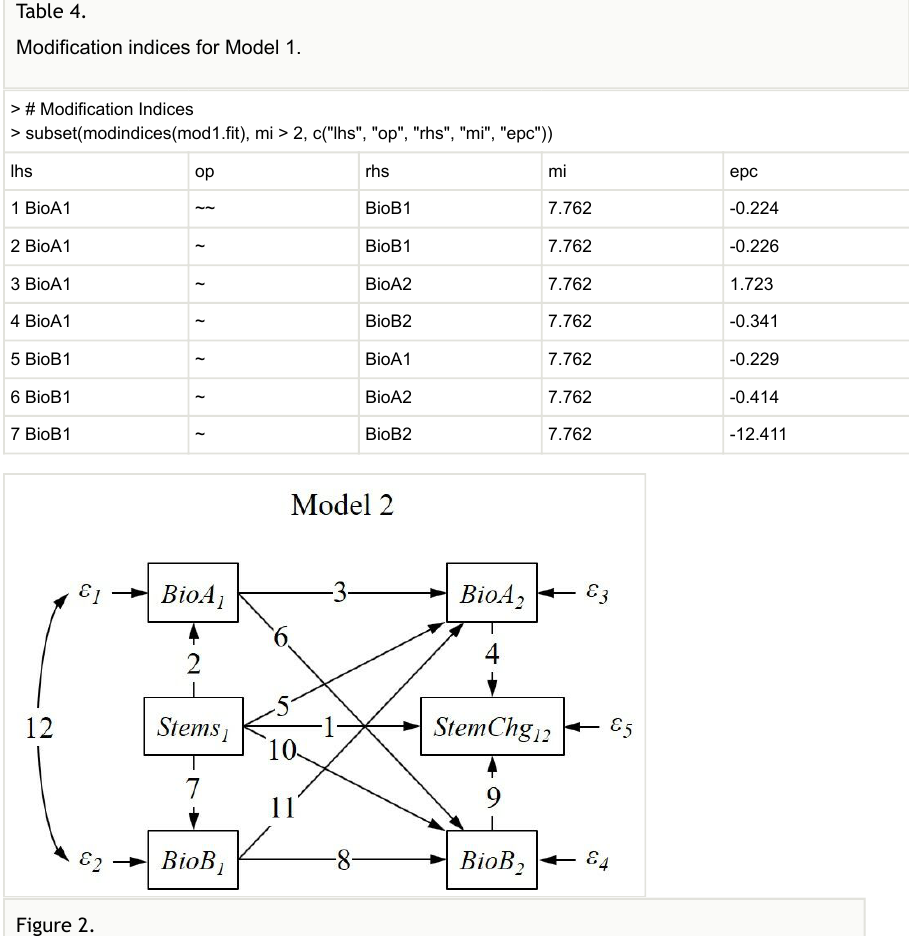
Model 2, which includes an error correlation between species A and B at time 1 (parameter